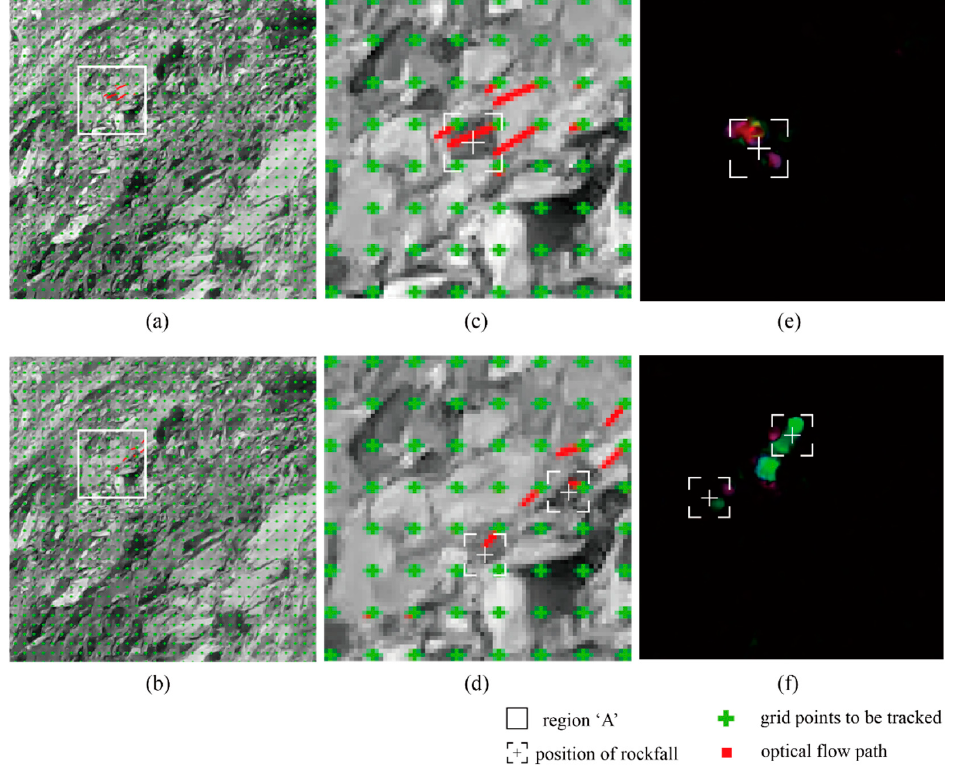
Figure 9. Results of dense optical flow analysis using Farnebäck method: ( a ) generated grid points (green cross) and optical flow paths (red) of test #4; ( b ) test #5; ( c ) enlarged image of test #4; ( d ) test #5; ( e ) tracked rock in an enlarged color map of test #4; ( f ) test #5.